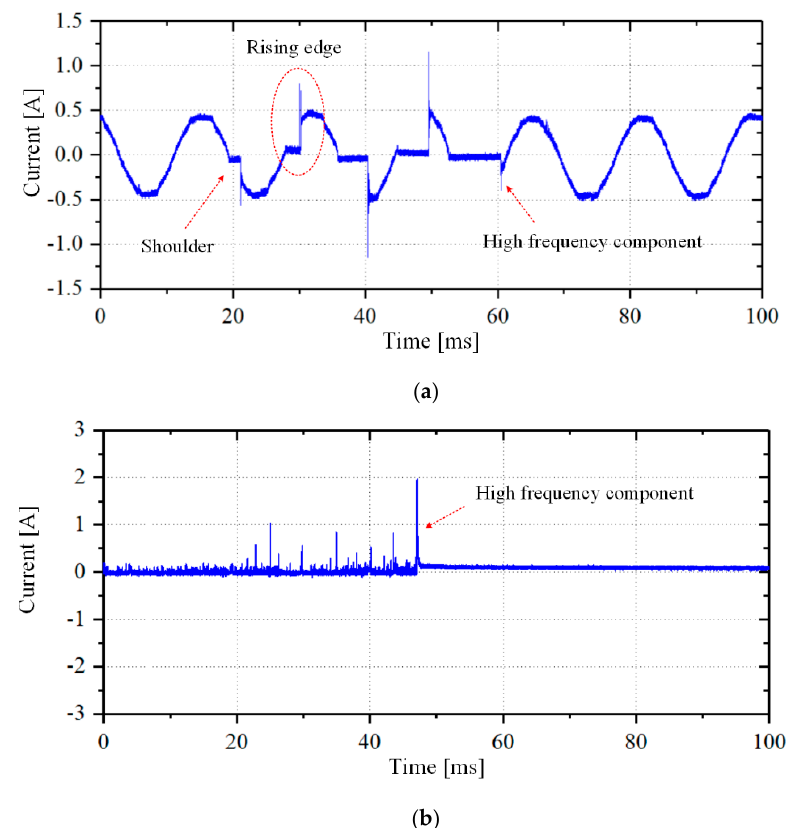
Figure 3. Typical current signal of series arc. ( a ) under AC voltage; ( b ) under DC voltage.